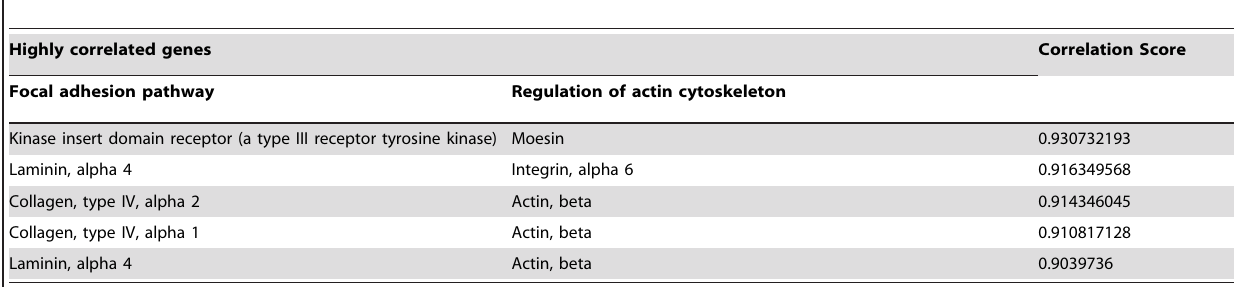
Highly correlated